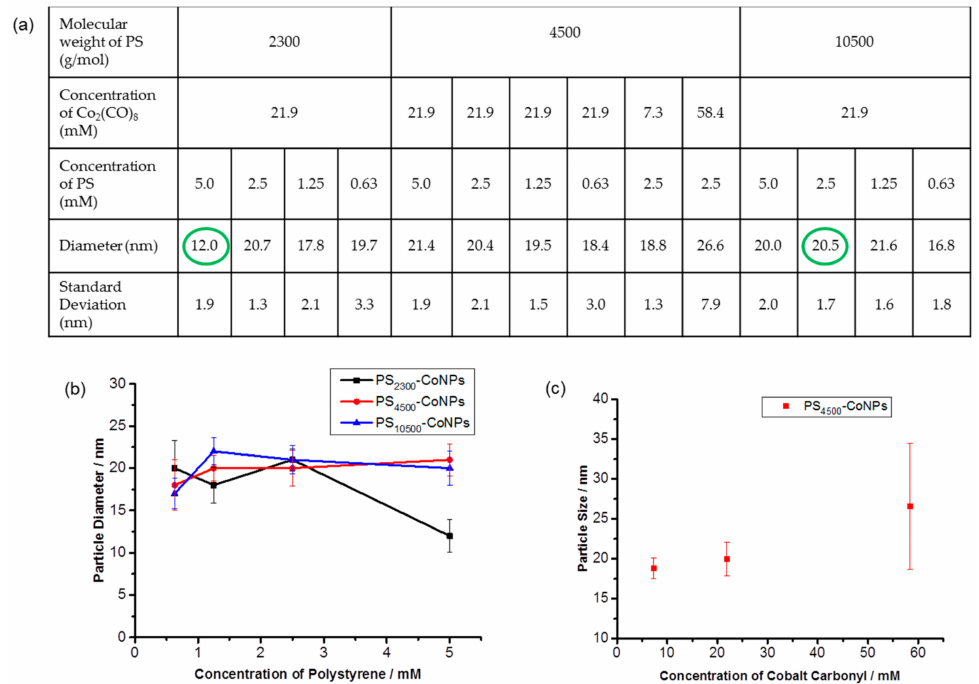
Figure 6. ( a ) Overview of varied synthesis parameters and mean diameters of the as-synthesized PS–Co NPs; ( b ) plot of size distribution of PS–Co NPs synthesized by fixing the concentration of cobalt carbonyl at 21.9 mM, the concentration and molecular weight of PS–NH 2 was varied; ( c ) plots of size distribution of PS–Co NPs synthesized by fixing the concentration of PS–NH 2 (2.5 mM, M n = 4500 g/mol), while varying the concentration of cobalt carbonyl ( C Co ). The mean size and standard deviation were obtained from a sample of around 200 NPs using ImageJ